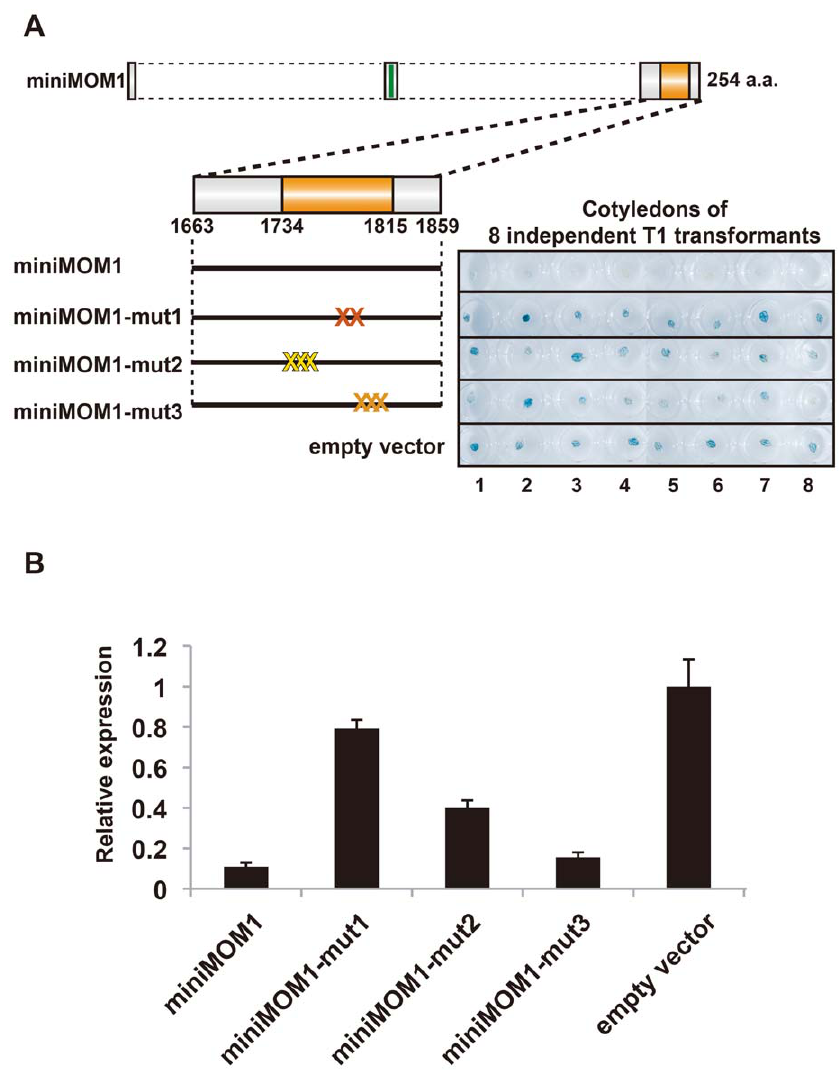
Figure 4. Multimerization of CMM2 domains are crucial for TGS activity. (A) Left , schematic models of transgene constructs used for transgenic complementation assays in mom1 L5 plants. ‘‘X’’ represents mutations colored as in Figure 3. Right , histochemical GUS staining of cotyledons of eight independent 1-week-old T1 transgenic plants transformed with the corresponding mutant derivatives of miniMOM1. The ‘‘empty vector’’ control corresponds to mom1 L5 transformed with a vector construct without miniMOM1. (B) Relative levels of GUS mRNA in T2 plants from 3 independent T1 plants determined by quantitative RT-PCR and normalized to 18S rRNA. The mean of the ‘‘empty vector’’ control was set to 1. Error bars represent S.E. calculated from 3 experimental sets of 40 to 50 plants